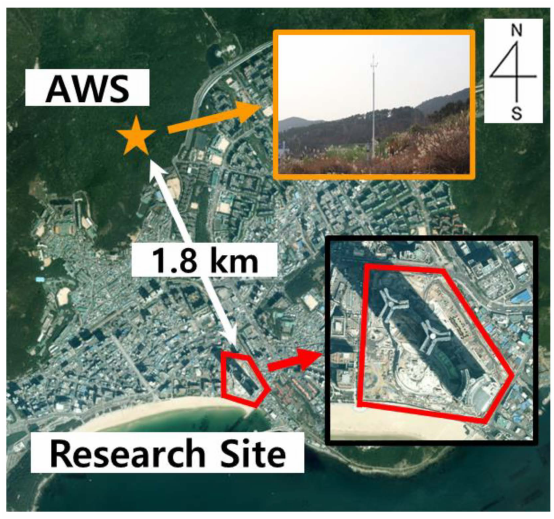
Figure 6. Locations of the study site and